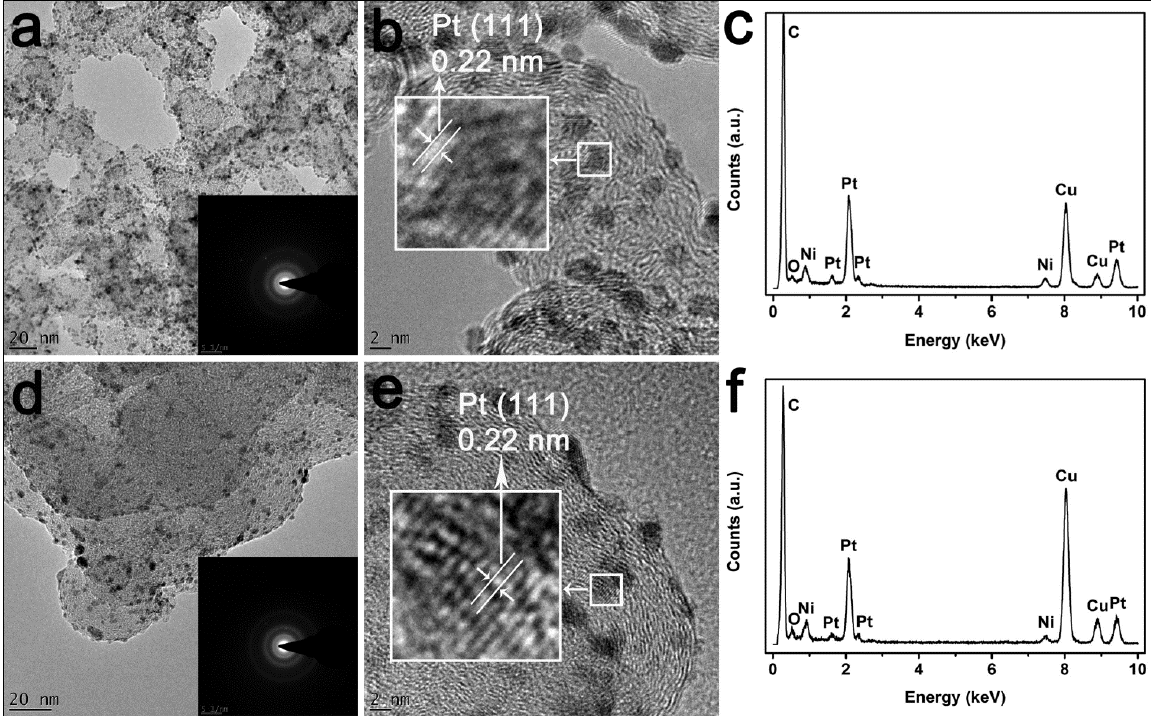
Figure 4. Transmission electron microscopy (TEM), high-resolution TEM (HRTEM) images and EDS spectrum of Pt-Ni Inset of ( a ) and ( d ) show the selected area electron diffraction (SAED) patterns of Pt-Ni and Pt-Ni /C A